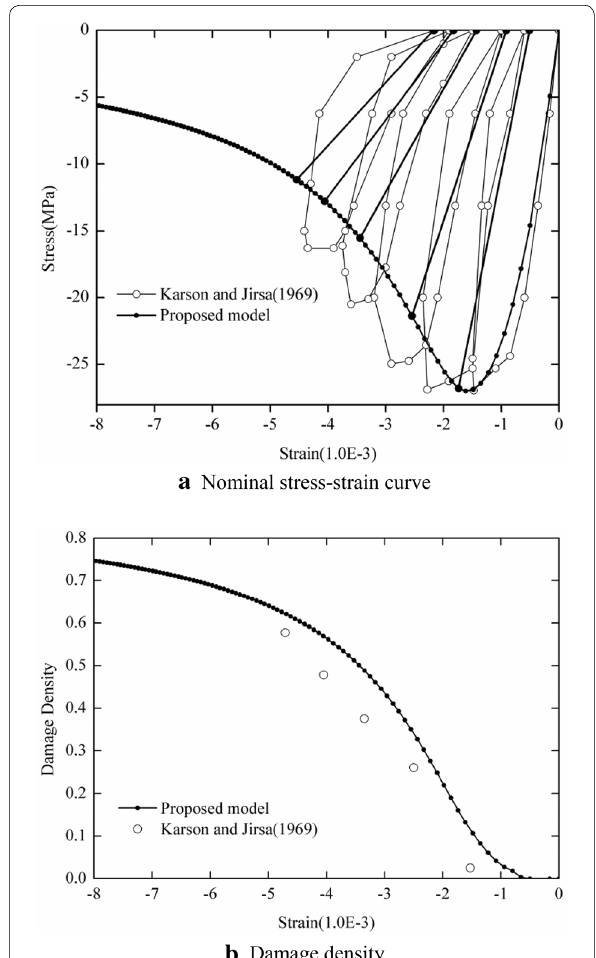
Fig. 6 The model responses in cyclic compression compared to experimental results presented in Karsan and Jirsa